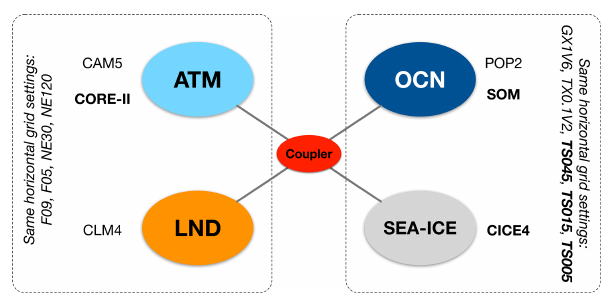
Figure 1. Ocean and sea ice grids and air–sea coupling in the Com- munity Earth System Model